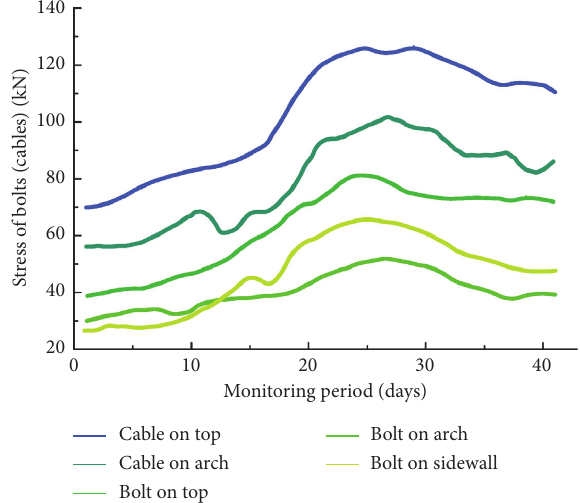
Figure 2: Stress variation curve of bolt and cable bolt under the influence of high ground